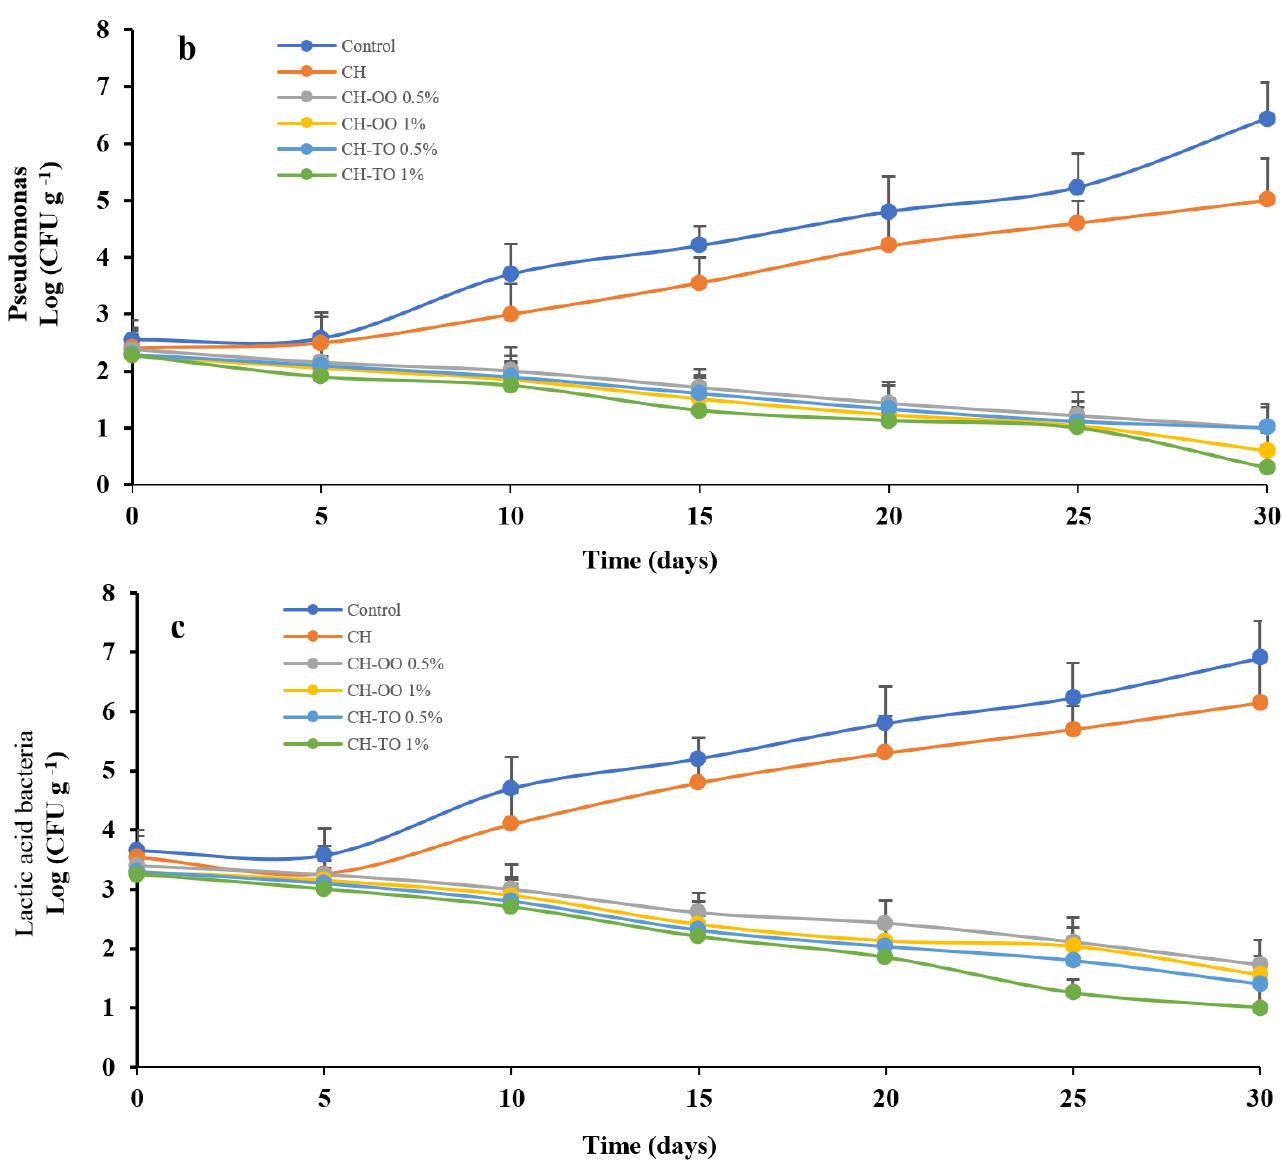
Figure 3. Antimicrobial activity of chitosan (CH) film incorporated oregano (OO) and thyme (TO) essential oils on Psychrophilic bacteria ( a ) Pseudomonas ( b ), and lactic acid bacteria ( c ) in the top round of beef during storage time. Error bars indicate standard deviation, ( n = 3). Control: without film and oil; CH: chitosan; CH − OO 0.5%: chitosan+ oregano oil 0.5%; CH − OO 1%: chitosan+ oregano oil 1%; CH − TO 0.5%: chitosan+ thyme oil 0.5%; CH − TO 1%: chitosan+ thyme oil